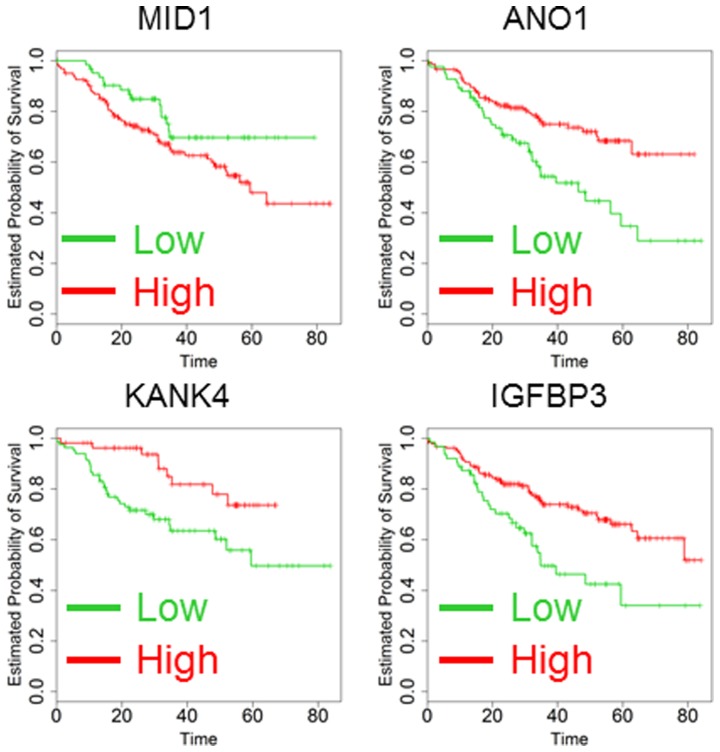
Kaplan-Maier analysis of 267 patients according to the analysis of MID1, ANO1, KANK4 and IGFBP3 expression.Kaplan-Maier analysis was performed dividing the patients as high (green) and low (red) setting. Survival time scale is in months. All the differences were significant and p-values are reported in Table 3 (Log-rank test).